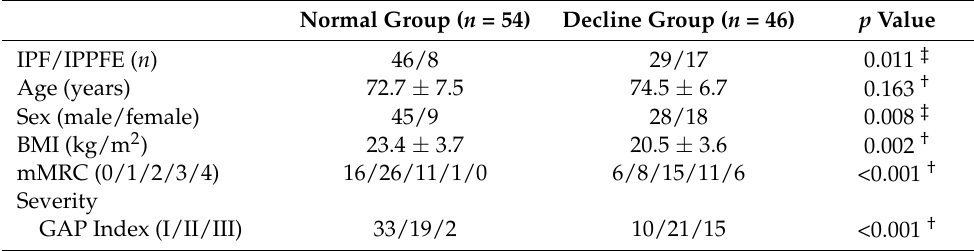
Table 2. Comparisons between groups by %6MWD ( ≥ 80% or